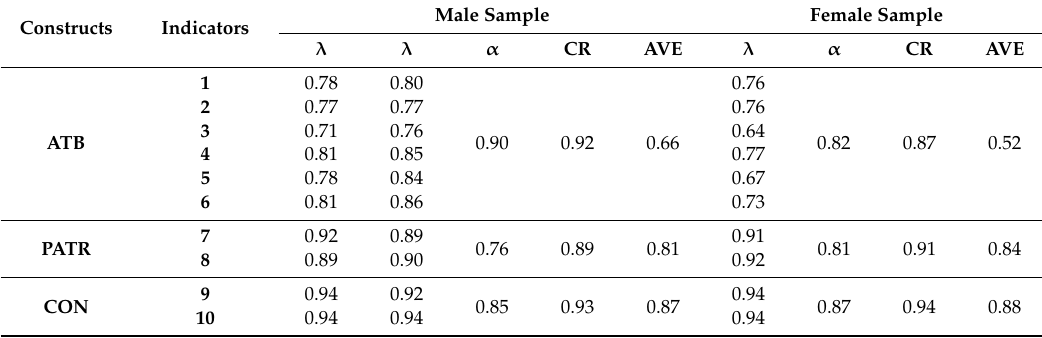
Table 1. Indicators, loadings ( λ ), alpha de Cronbach ( α ), Compose Reliability (CR), and AVE of the total, male, and female